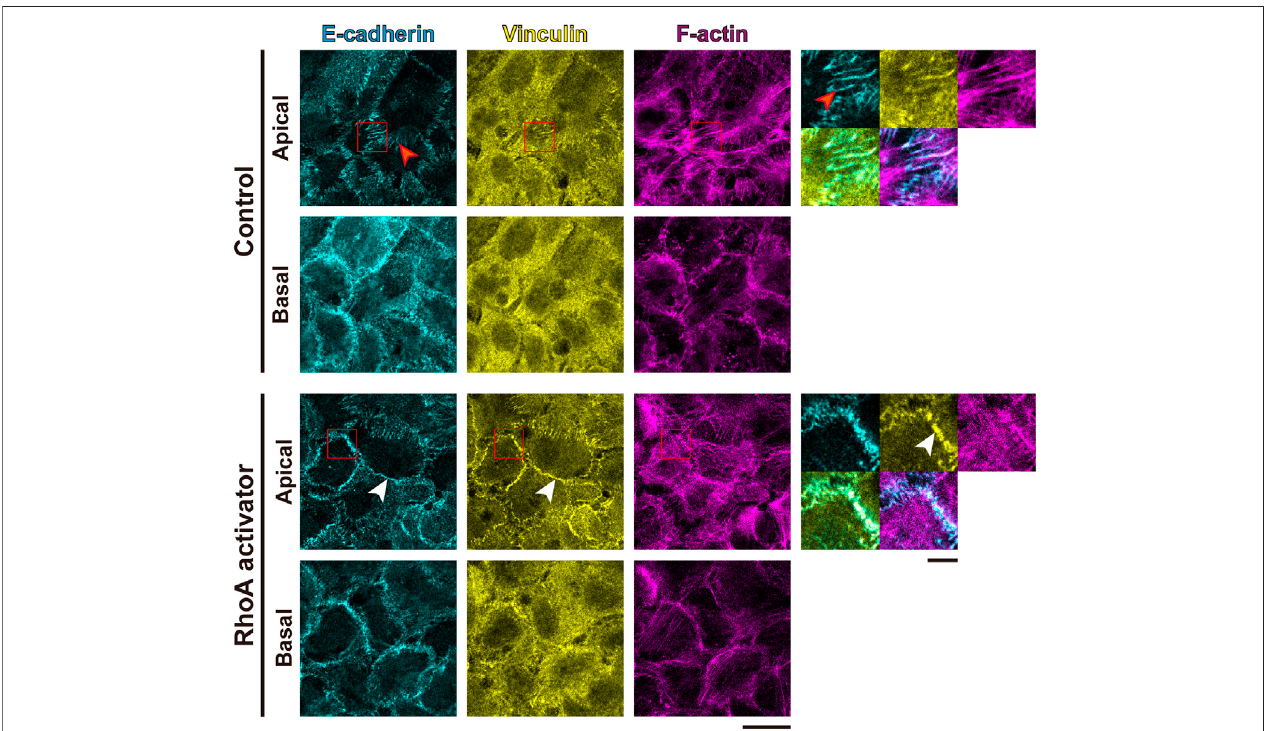
FIGURE 3 | RhoA activation increases tensile loads at adherens junctions but not focal adhesions in cSCC cells. Con fl uent A431 cells were treated with or without 5 μ g/ml RhoA activator (RhoA act.) and stained for E-cadherin (cyan), F-actin (magenta), and vinculin (yellow). Apical and basal focal planes of the cells are shown. Magni fi ed images of the boxed regions are also shown. The red arrowheads indicate zipper-like AJs, and the white arrowheads indicate continuous AJs. Scale bars, 5 μ m for magni fi ed images, and 20 μ m for others.